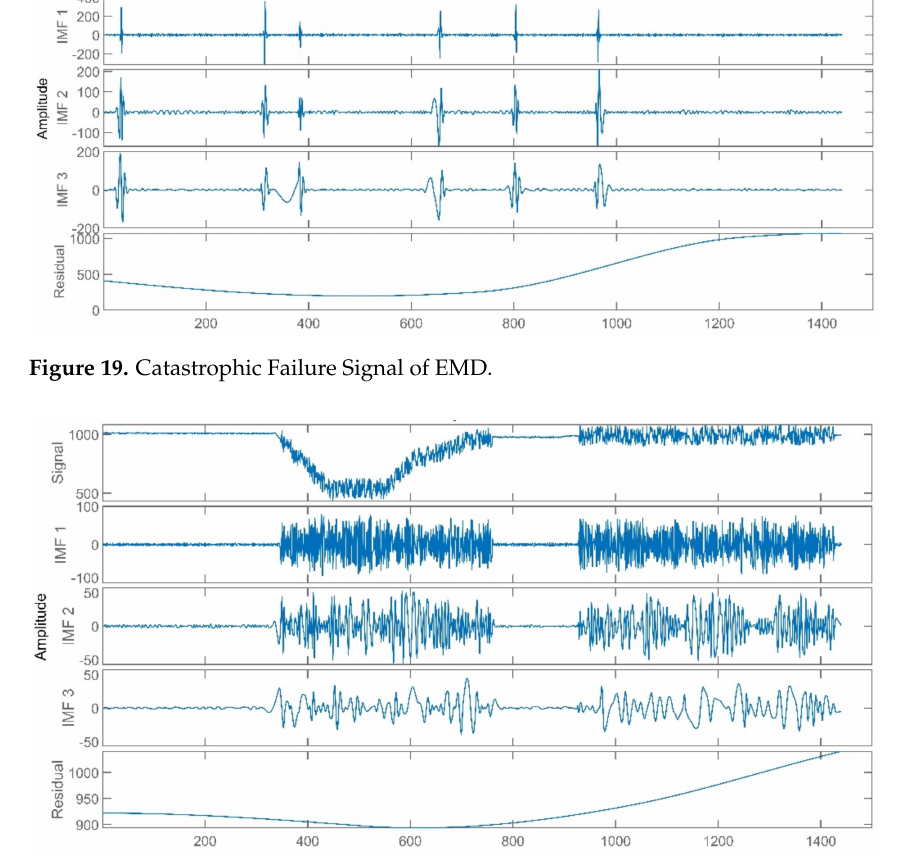
Figure 20. Precision Degradation Failure Signal of